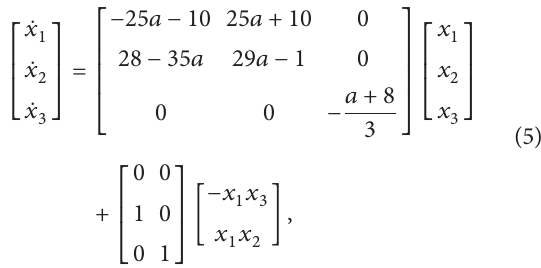
channel are only the chaotic output 𝑦 , not full system